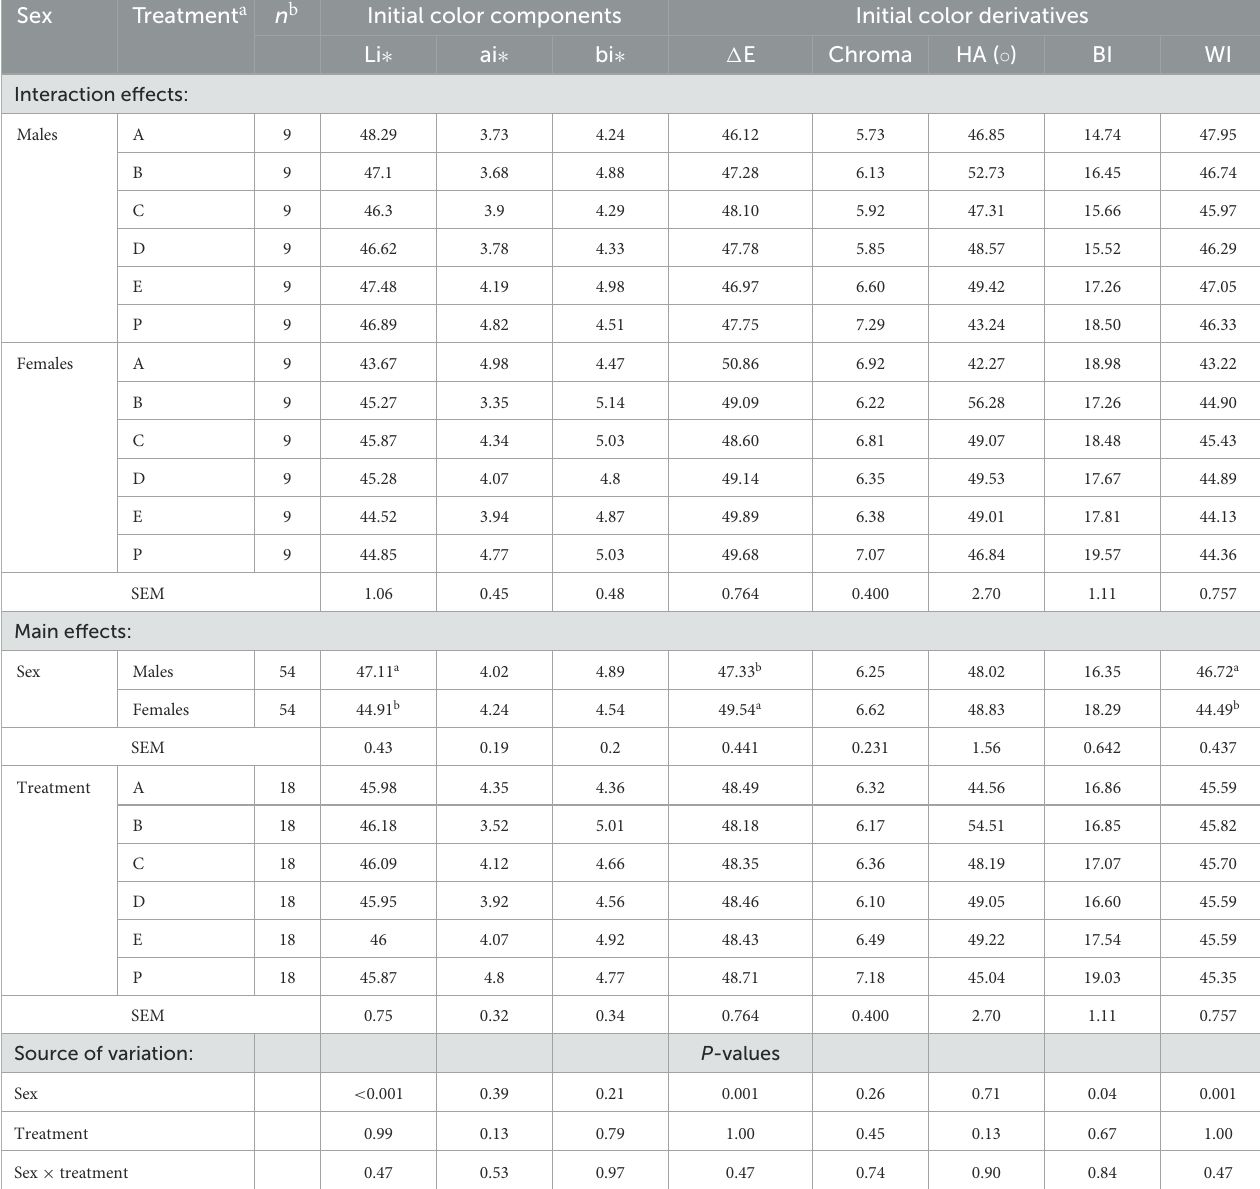
TABLE 2 Effects of adding nano-emulsified plant oil and probiotics to drinking water during different periods besides sex on initial color components and its derivative of breast meat of broiler chickens at 35 days of age.